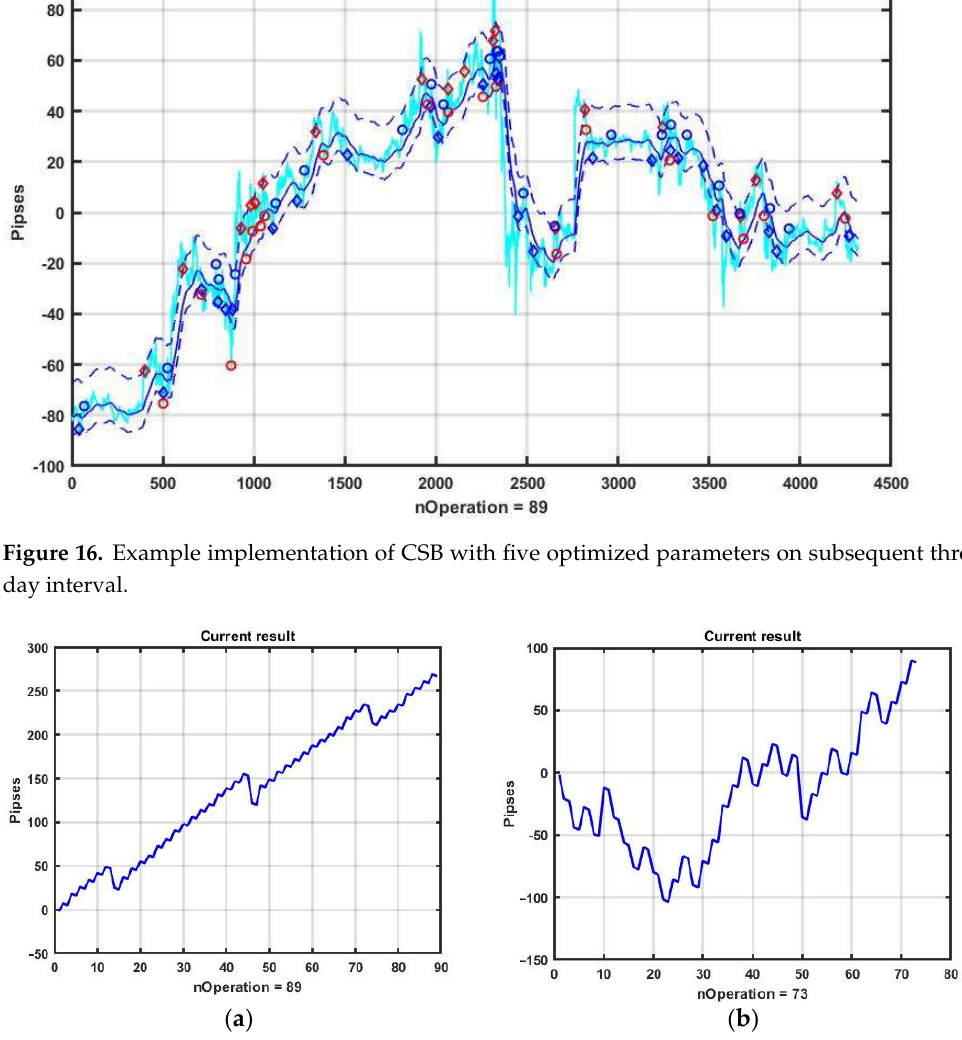
Figure 17. Performance of optimized control after applying the CSB strategy in the observation area with optimization ( a ); and in the subsequent interval of the same duration ( b ).